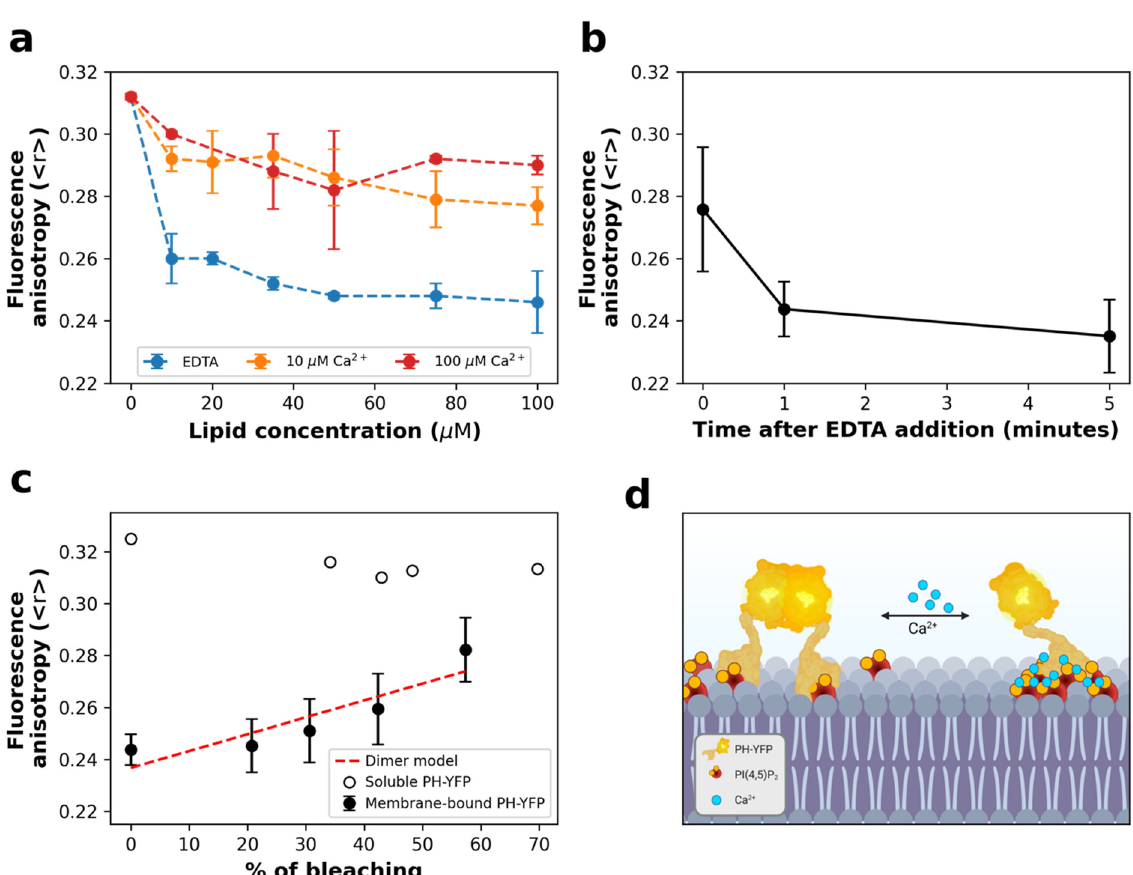
Figure 1. PH-YFP partitions to PI(4,5)P 2 containing LUVs and undergoes significant oligomerization in the absence of Ca 2+ . ( a ) PH-YFP partition to POPC:PI(4,5)P 2 (95:5 molar ratio) LUVs, followed through changes in steady-state fluorescence anisotropy, in the presence of 10 μ M Ca 2+ (orange), 100 μ M Ca 2+ (red), and 5 mM EDTA (blue). Dashed lines are just a guide to the eye. ( b ) Kinetics of fluorescence anisotropy response to the addition of 5 mM EDTA to PH-YFP and PI(4,5)P 2 containing LUVs in the presence of 100 μ M Ca 2+ . Total lipid concentration was 100 μ M. ( c ) Photobleaching assay of 100 μ M PH-YFP, both in solution (empty circles) and incubated with POPC:PI(4,5)P 2 (95:5 molar ratio) LUVs, in the presence of 5 mM EDTA (full circles). ( d ) Illustration of PI(4,5)P 2 -bound PH-YFP dimerization modulation by Ca 2+ . Created with BioRender.com. Values represent means ± standard deviations. Values for each condition are averages of three different independent